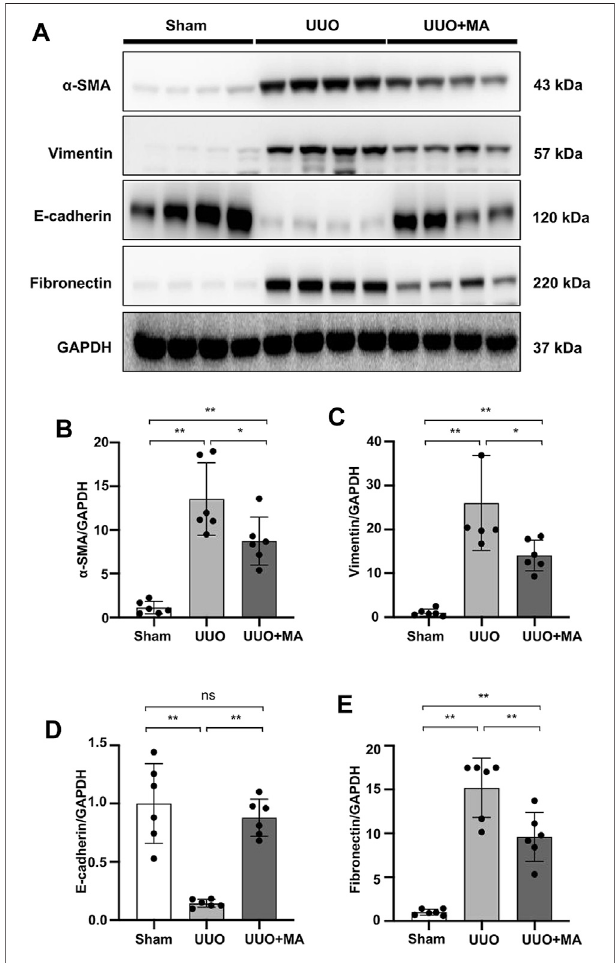
FIGURE 2 | MA inhibits renal tubular ECM deposition and EMT in the UUOmodel. (A) Expressionof α -SMA,vimentin,E-cadherin,and fi bronectinin kidney tissues was detected by western blot and quanti fi ed by densitometry. (B – E) Statistical signi fi cance was presented as the mean ± SD, n (cid:1)